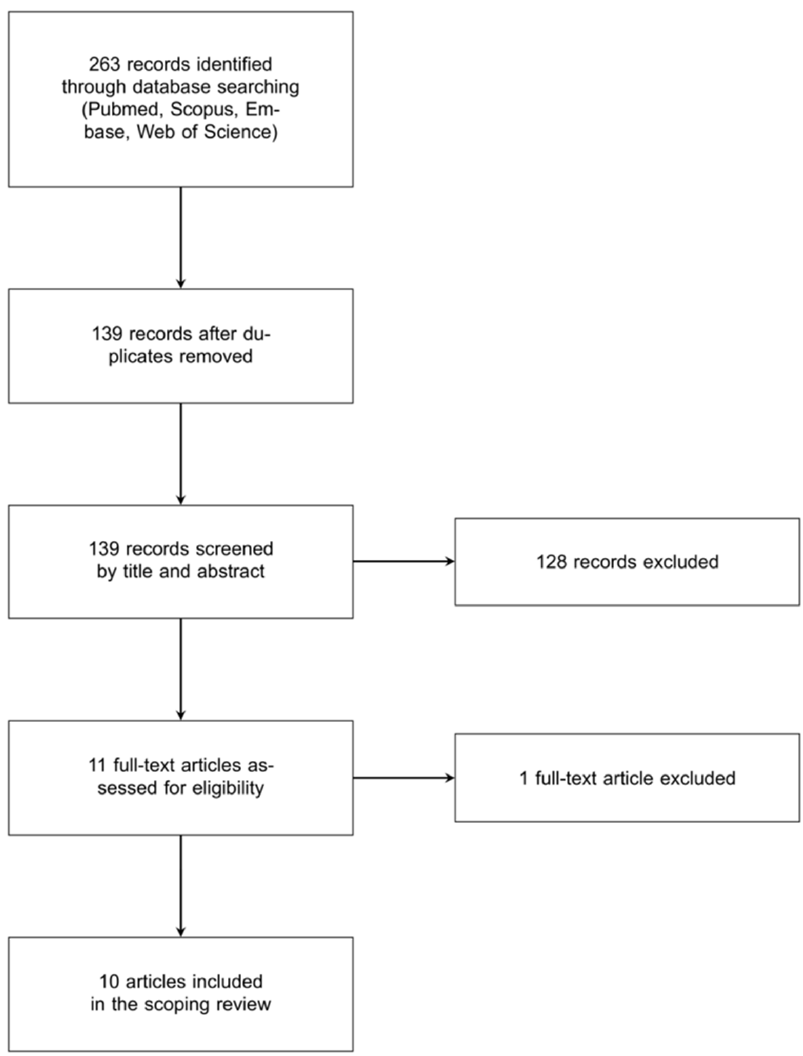
Figure 1. Review process flow diagram.